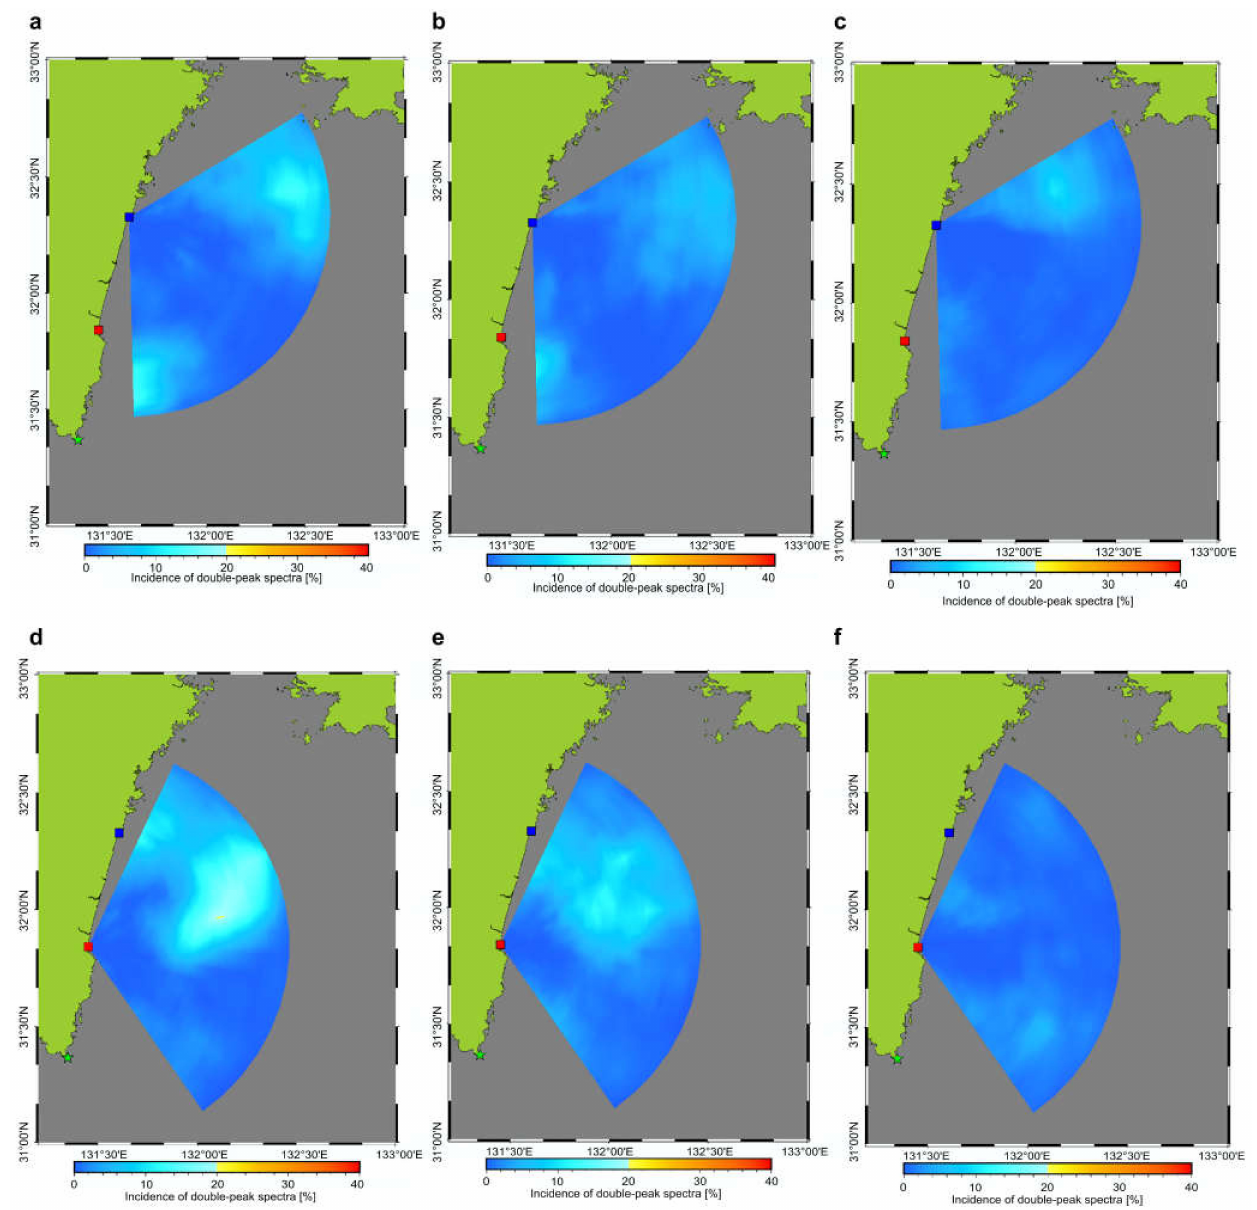
Figure 8. Changes in the spatial distribution of double-peak spectra at two-month intervals from March to July 2019 (period 1 (cid:13) ). Mimitsu Station in ( a ) March 2019, ( b ) May 2019, and ( c ) July 2019. Miyazaki Station in ( d ) March 2019, ( e ) May 2019, and ( f ) July